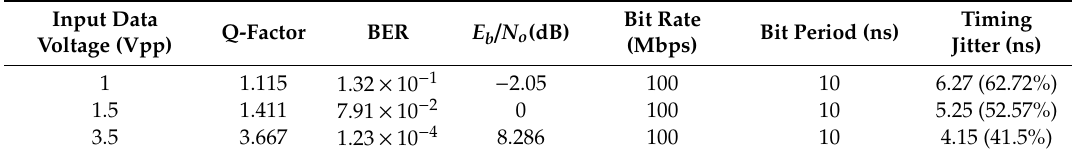
Figure 6. Real-time received QPSK signal reconstruction using VSA code for transmitted 3.5 Vpp PRBS signal. ( a ) IQ constellation and ( b ) eye pattern.